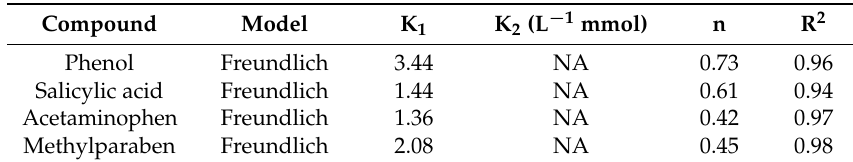
Table 10. Parameters of Freundlich model for phenol, acetaminophen, salicylic acid, and methylparaben adsorption on activated carbon CAR1073.